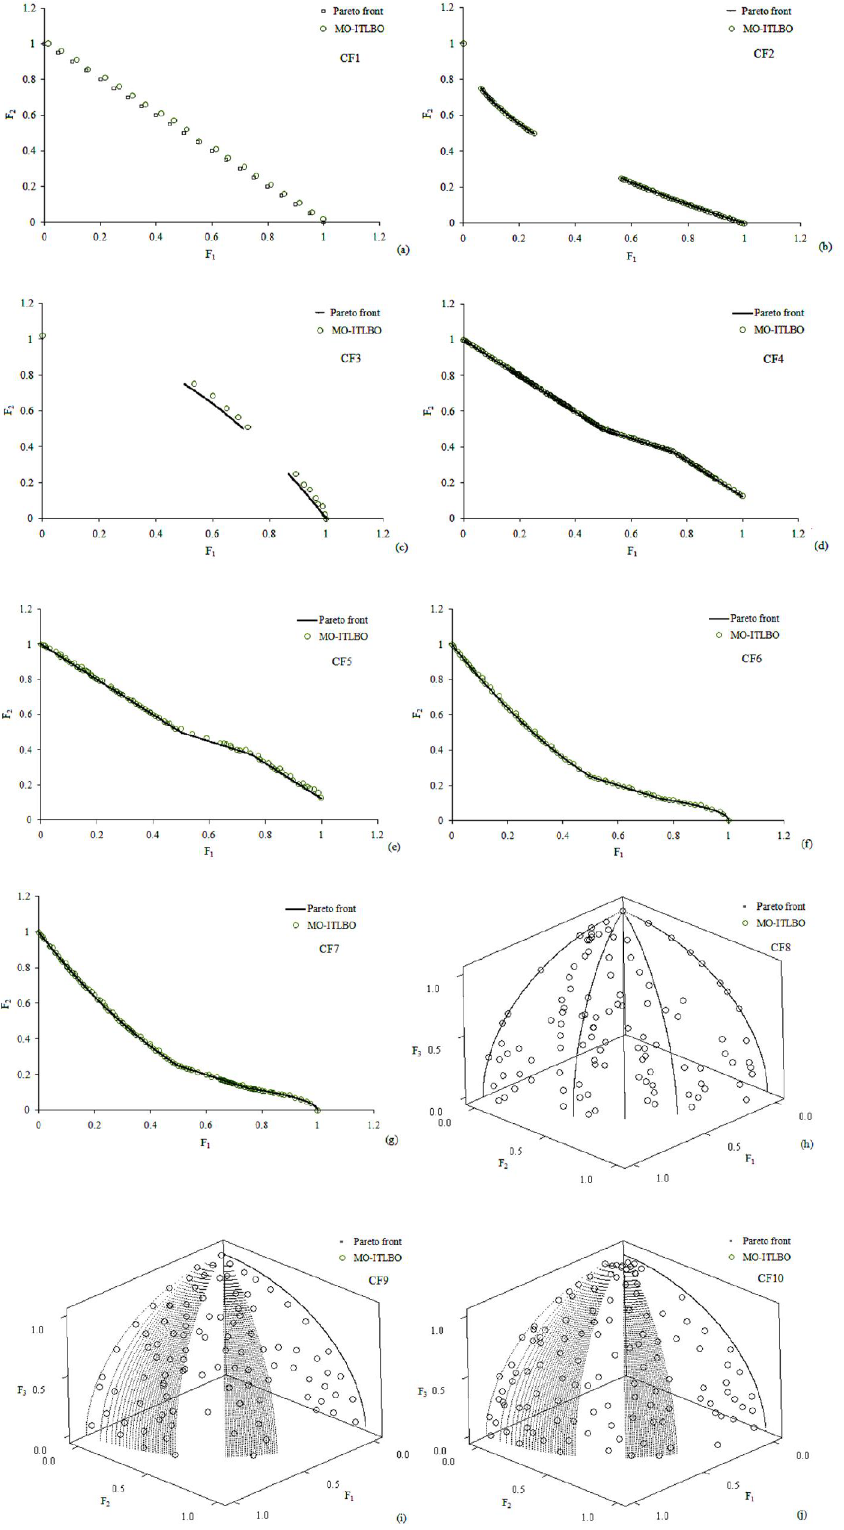
Fig. 4(a)-(j). The Pareto front obtained by the MO-ITLBO algorithm for constrained test